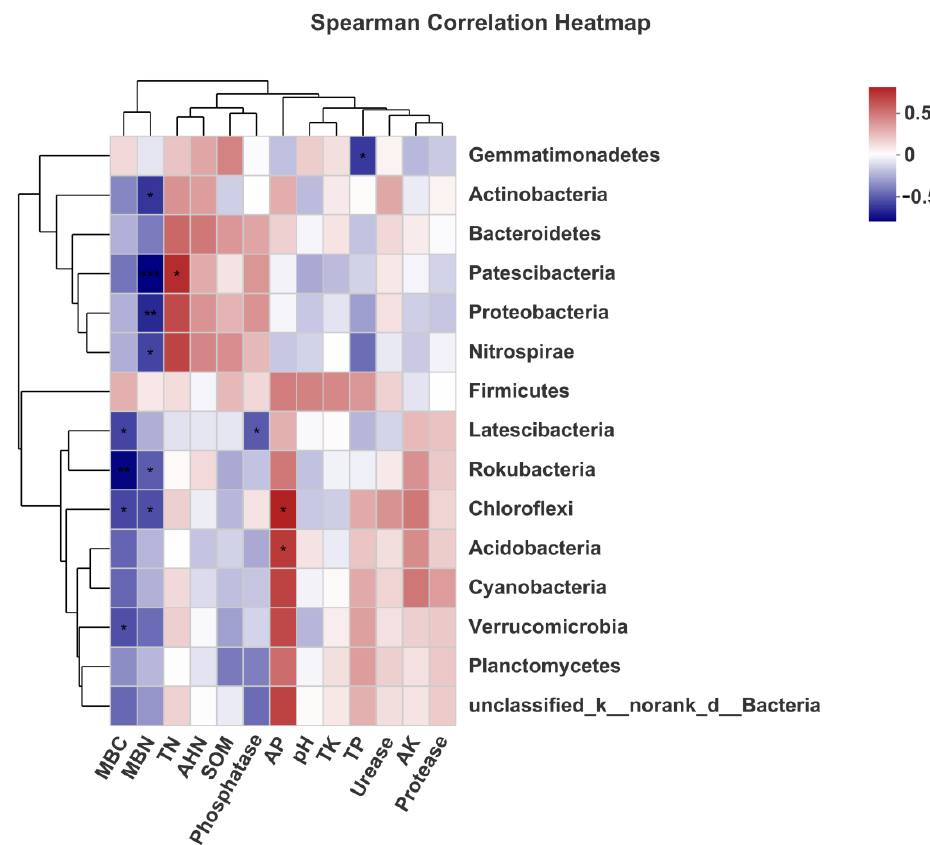
Figure 4. The correlation heatmap analysis between environmental factors and species of bacterial by Bray-Curtis distances (based on phylum level). SOM, soil organic matter; TN, total nitrogen; TP, total phosphorus; TK, total potassium; AHN, alkali-hydrolyzable nitrogen; AP, available phosphorus; AK, available potassium. “*” “**” indicates p < 0.05 and p < 0.01 significant correlation, respectively.